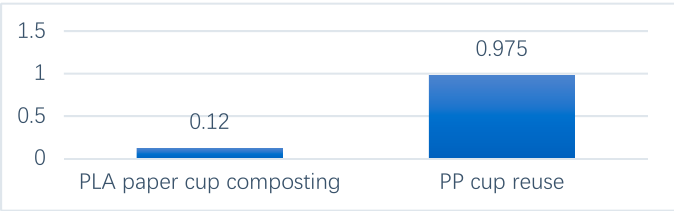
Figure 6. Material circularity indicator (MCI) of the polylactic acid (PLA) paper cup and polypropylene (PP) reusable